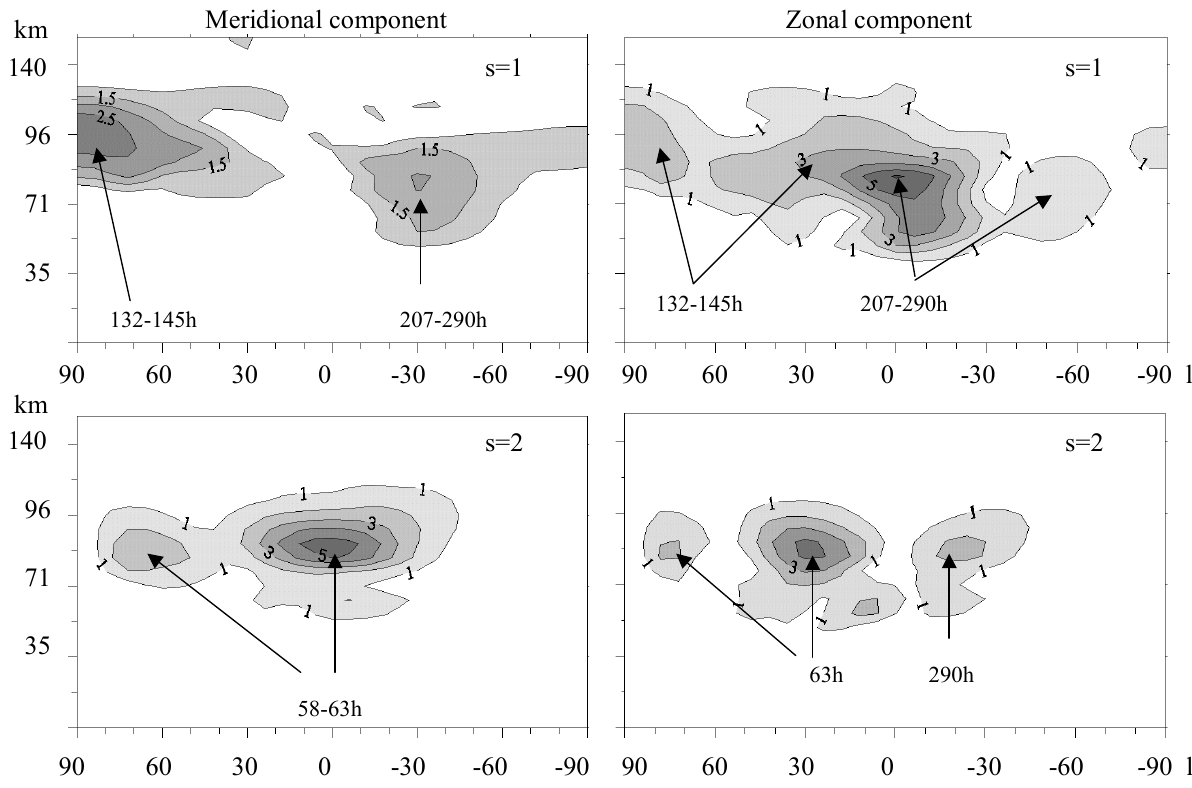
Fig. 4. Amplitudes (m/s) of secondary waves for zonal wave numbers 1 and 2, for the case of strong instability in the lowermost panel of Fig. 1. Periods (hours) are pointed at by arrows. Axis labels are latitude and approximate